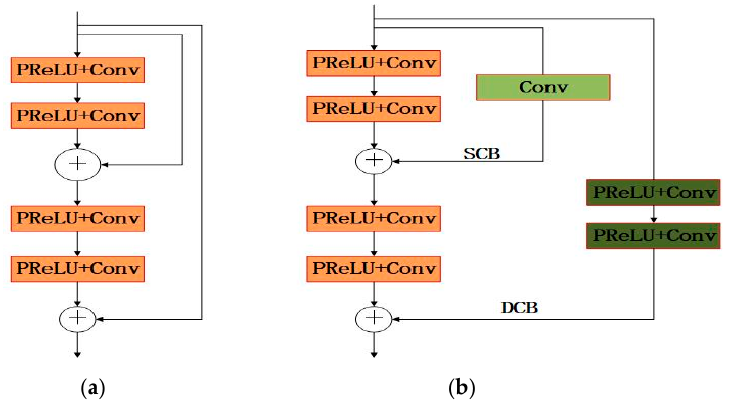
Figure 3. ( a ) The partially simplified structure of DRRN. ( b ) The structure of LRB with a shallow convolutional branch (SCB) and a deep convolutional branch